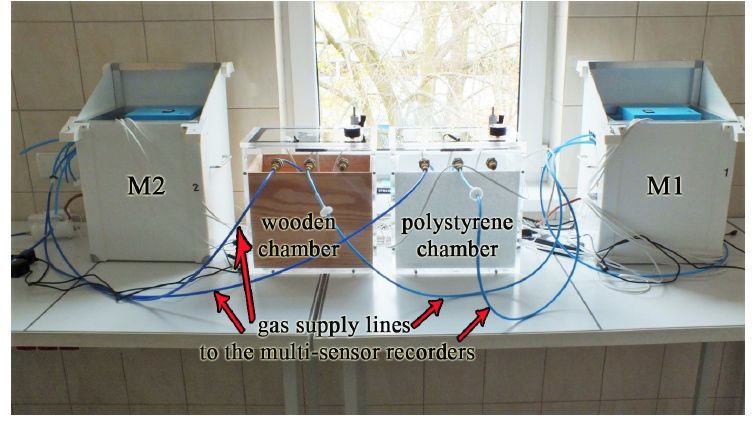
Figure 2. The measurement stand.